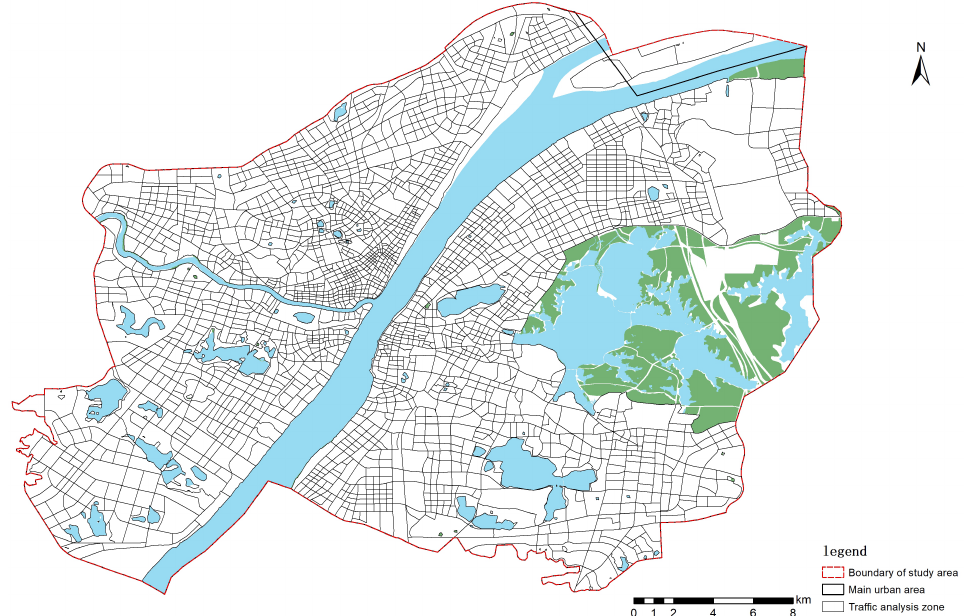
Figure 2. Comparison of main urban area scope and study